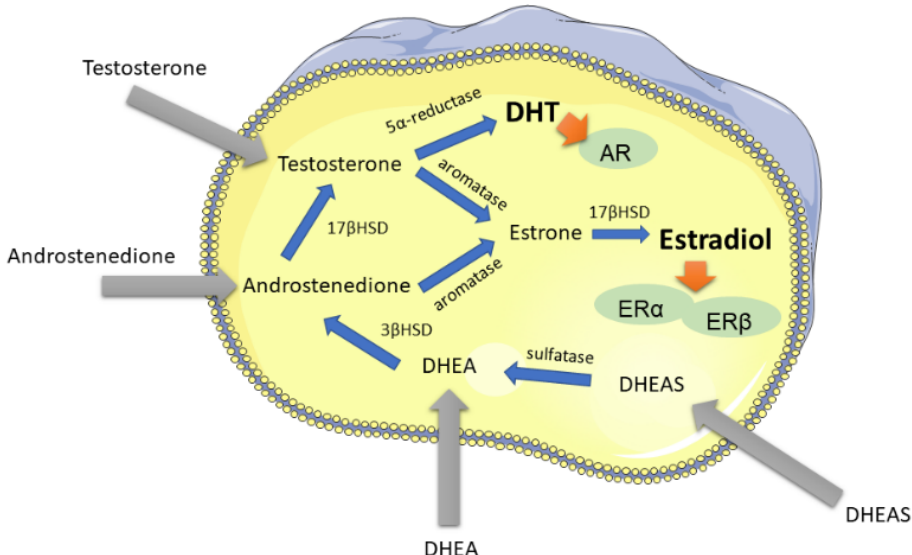
Figure 4. Schematic overview of intracrine hormonal processing pathways in non-gonadal peripheral cells. Steroid precursors such as DHEA, DHEAS, androstenedione or testosterone originate from the adrenal cortex. After cellular uptake, precursor forms are processed to more potent sex steroid hormones, e.g., DHT or estradiol for further androgen or estrogen receptor binding and intracrine nuclear signaling. DHEA dehydroepiandrosterone, DHT dihydrotestosterone, 17 β HSD 17-beta-hydroxysteroid dehydrogenase, AR androgen receptor, ER estrogen receptor.